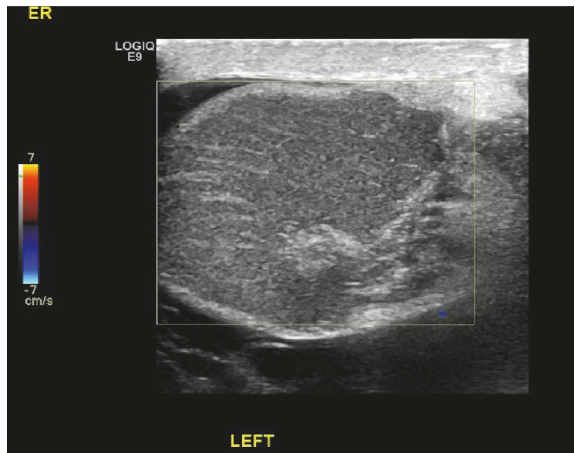
Figure 1: Scrotal ultrasonography showed absent testis blood flow.